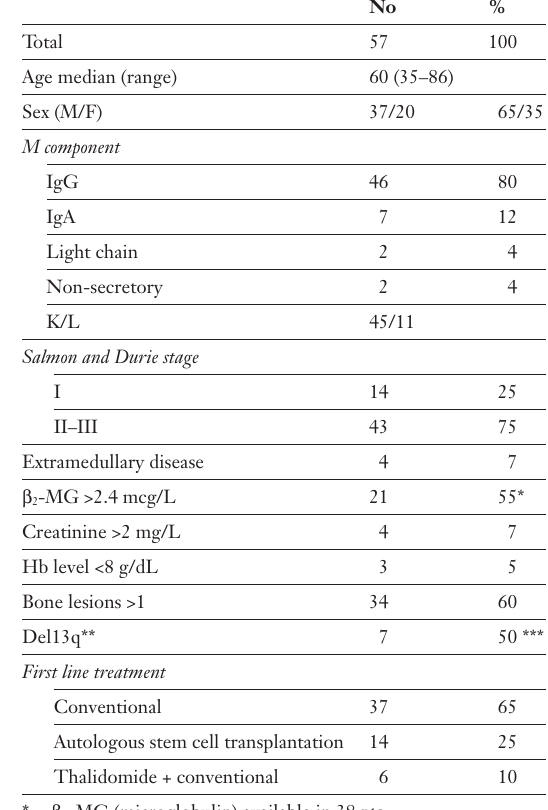
Kaplan Meier estimate of probability of TTF in previously untreated multiple myeloma patients according to COX-2 expression status at diagnosis. Dotted line indicates COX-2 positive and solid line COX-2 negative patients by immunohistochemical expression analysis (p =